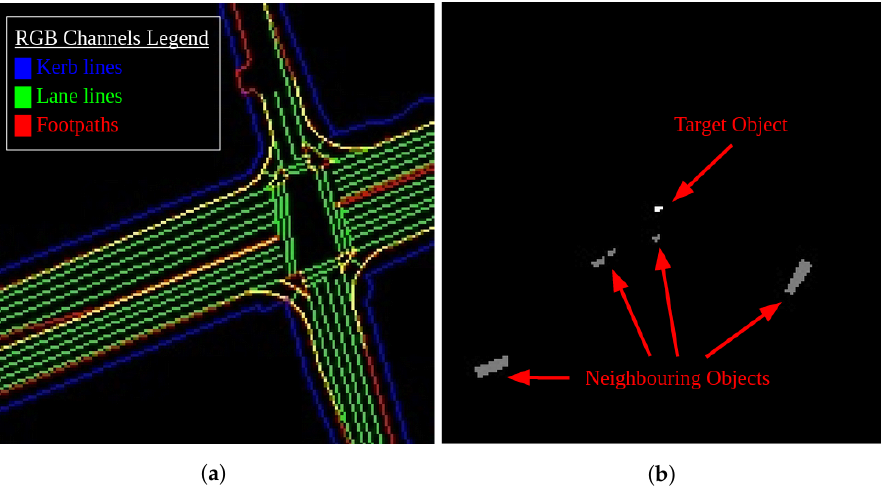
Figure 8. Semantic map layers used as part of the network input. The map data with road, lane, and kerb information were taken from the Singapore Land Transport Authority’s public database, further described in Section 8.1. ( a ) Semantic map showing the first three layers of the semantic map. ( b ) Semantic layer with neighboring obstacles in the